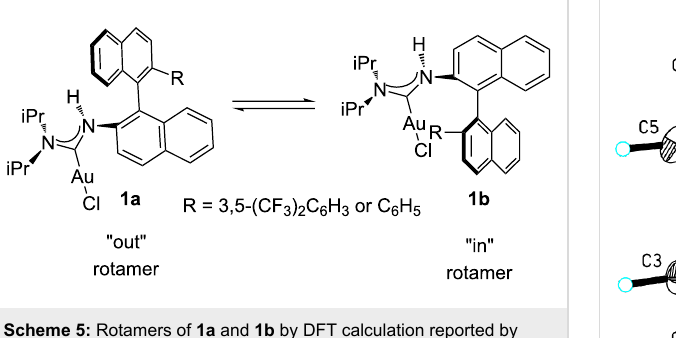
Scheme 5: Rotamers of 1a and 1b by DFT calculation reported by Slaughter’s group.